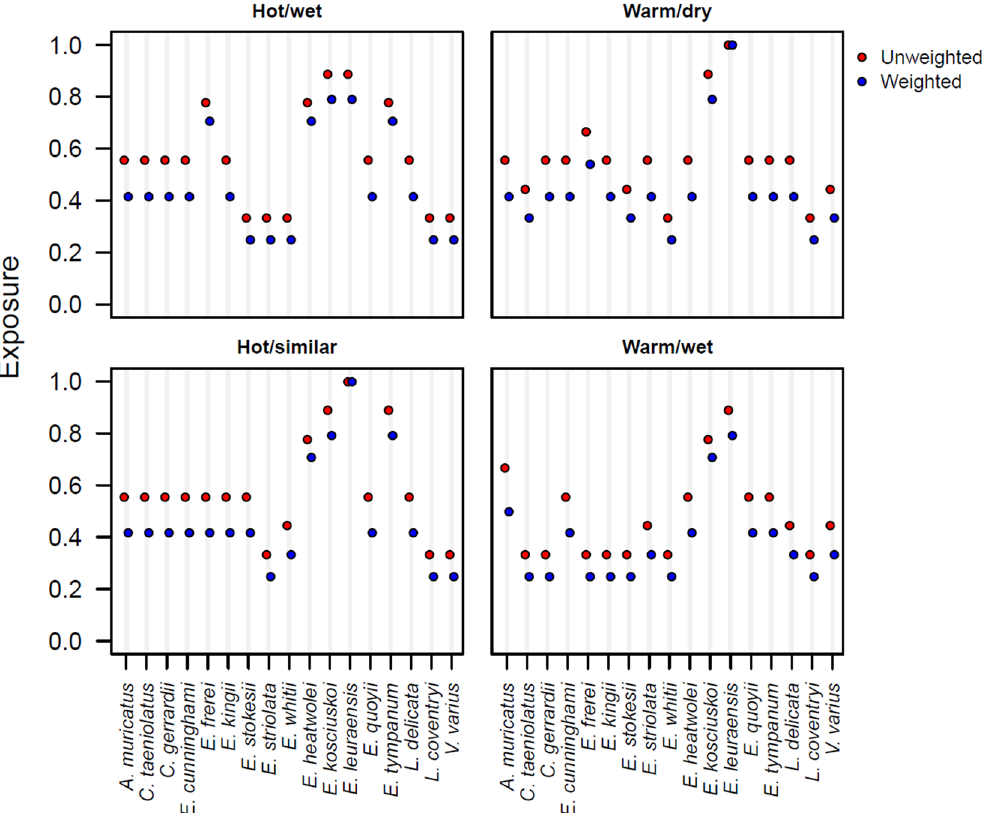
Figure 1. Weighted and unweighted exposure scores for 17 Australian lizards under projected climate change by 2050. Exposure was assessed using four contrasting future climate scenarios that are equally plausible: hot/ wet; warm/dry; hot/similar precipitation; and warm/ wet scenarios. Score ≥ 0.67 is high, from 0.33 to 0.66 is moderate and < 0.33 is low. See Supporting Information Figures S1 and S2 for exposure scores at 2030 and 2070.